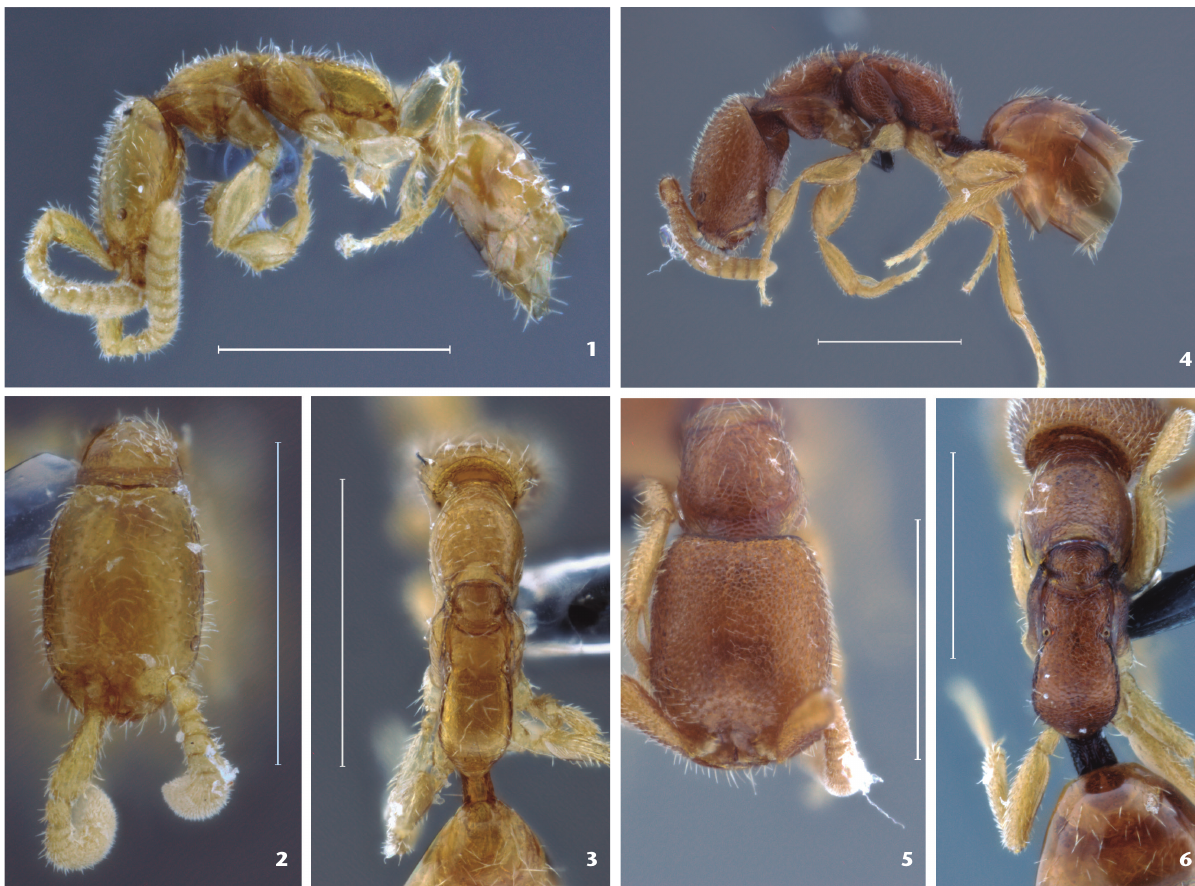
Figures 1-6. (1-3) Female of Dissomphalus simulatus from Bolivia: (1) habitus in lateral view; (2) head in dorsal view; (3) mesosoma in dorsal view. (4-6) Female of Dissomphalus mendicus from Brazil, Distrito Federal: (4) habitus in lateral view; (5) head in dorsal view; (6) mesosoma in dorsal view. Scale bars: 500